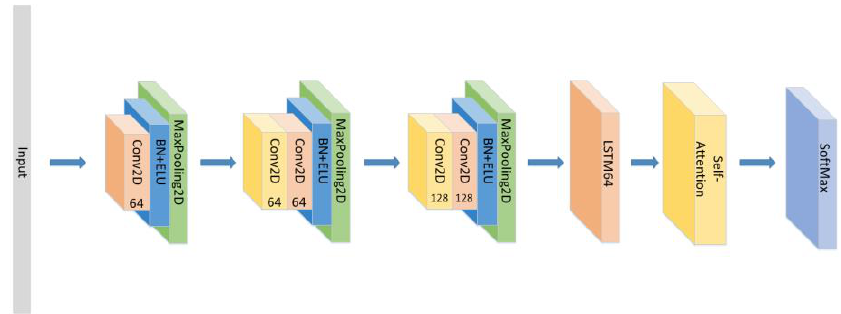
Figure 8. The construction of the CNN+LSTM×2+Self-Attention model.